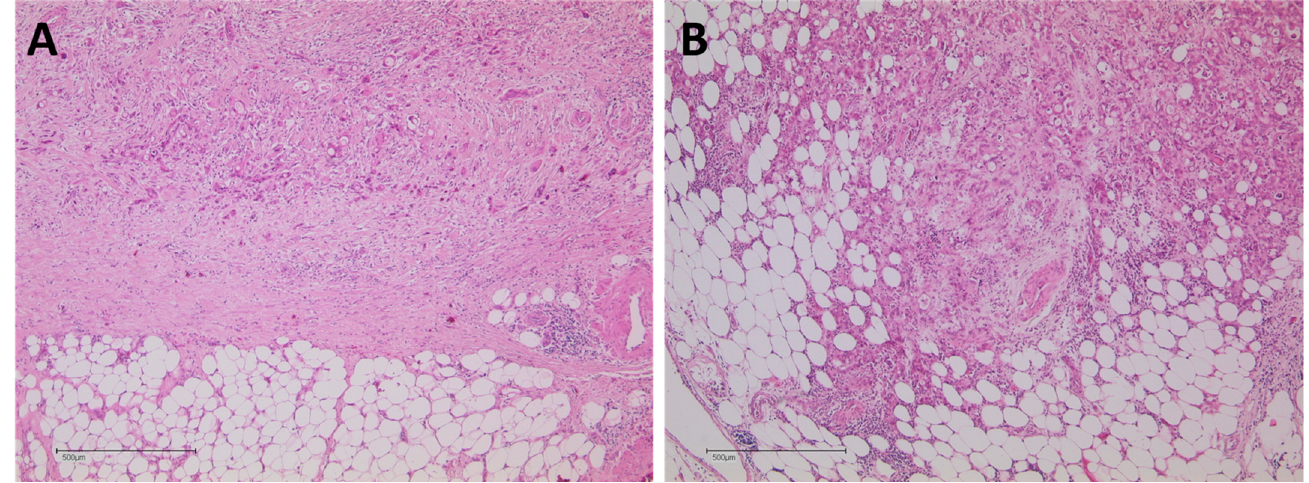
Figure 4. ( A ) Mesopancreatic fatty tissue without PDAC infiltration (H&E, 5×). ( B ) Mesopancreatic fatty tissue with abundant PDAC infiltration (H&E, 5×).